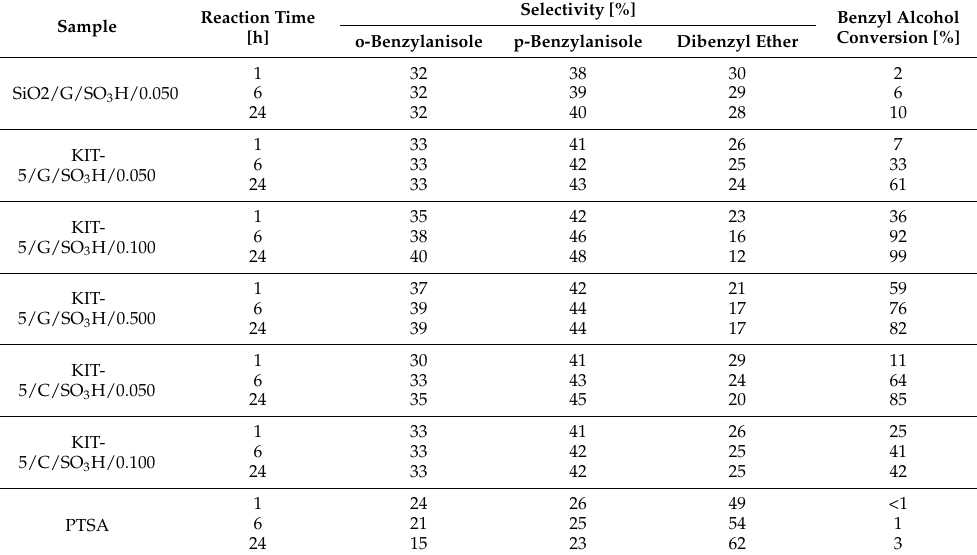
Table 5. Benzyl alcohol conversion and selectivity values for the products of Friedel–Crafts alkylation reaction carried out in the presence of KIT-5 type materials modified by sulfonic groups by grafting or co-condensation. Selectivity [%] Benzyl Alcohol Sample Reaction Time [h] Conversion [%]o-Benzylanisole